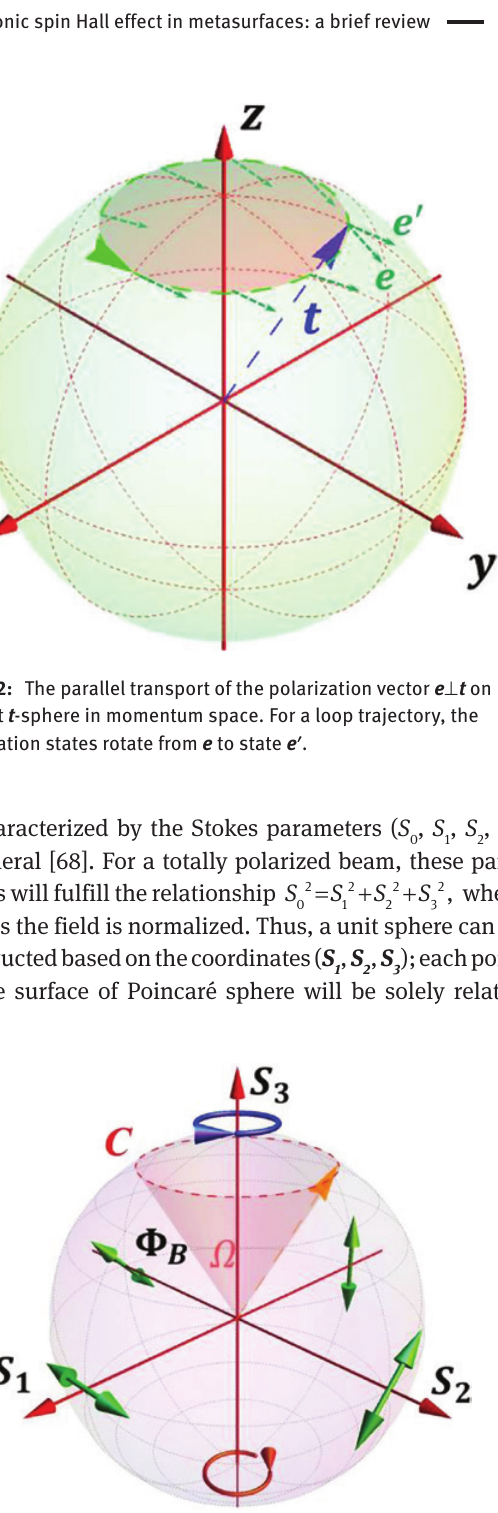
Figure 3: The polarization evolution is represented by the preces- sion of the Stokes vector ( S , S , S ) on the Poincaré sphere about 1 2 3 the S axis. The Stokes parameters are applied to characterize the 3 polarizations of light; for a polarized beam, they hold relationship + + = S S 1. Poles of this unit sphere represent circular polari- 3 zations, the equatorial points represent the linear polarizations, and the internal points are elliptical polarizations. The polarization states on the coordinate axes are marked by arrow